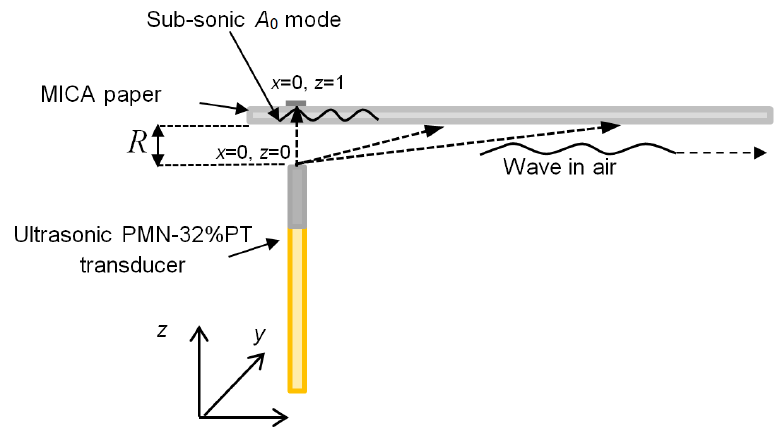
Figure 20. Excitation of the A 0 mode via air gap.